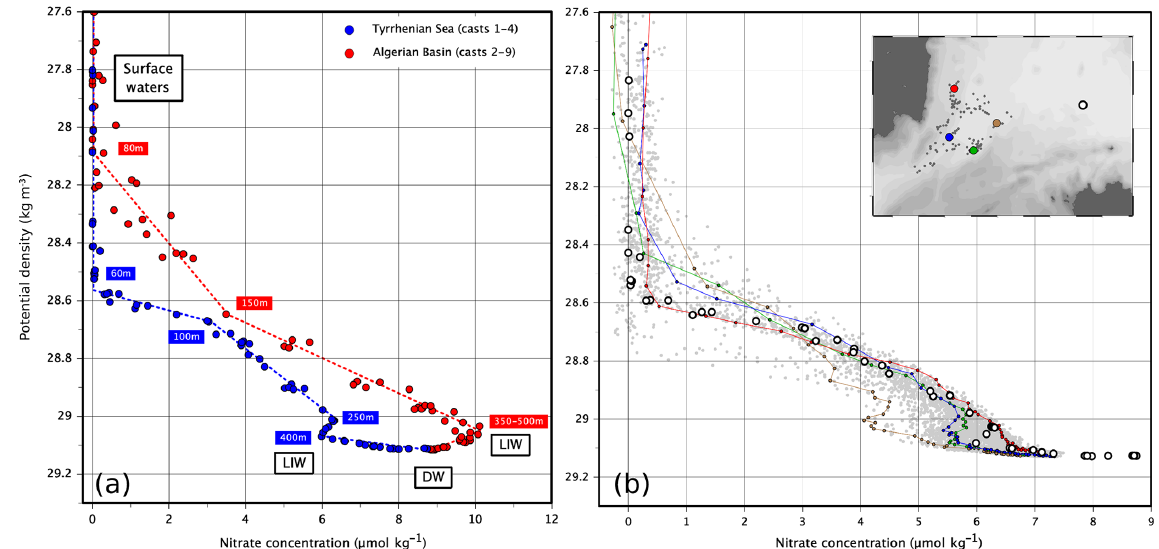
Figure 14. Potential density versus nitrate concentrations (µmolkg − 1 ). (a) Data from water samples collected during the PEACETIME cruise. Blue dots: casts A–D in the Tyrrhenian Sea (locations indicated in Fig. 3). Red dots: casts B–I in the Algerian Basin (locations indicated in Fig. 7). (b) Cruise data (open circles) and data from float 6901769 (grey dots) as well as float profiles of the 3 October 2015 (red), 29 November 2016 (green), 27 December 2016 (brown) and 11 April 2017